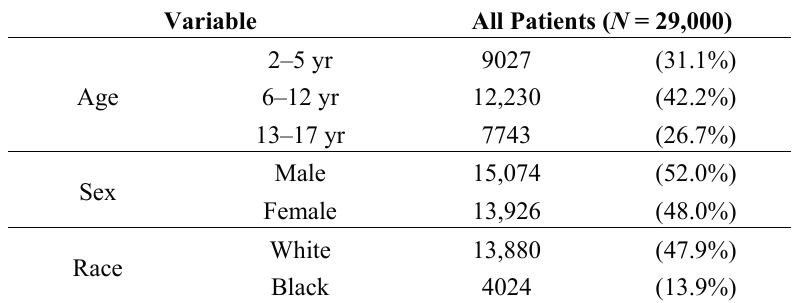
Table 2. Demographics of all patients seen in the participating